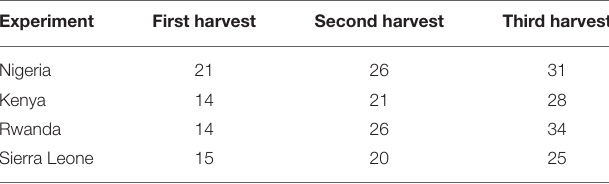
TABLE 4 | Harvesting periods (days after emergence for Nigeria, Kenya and Rwanda; days after planting for Sierra Leone) followed at each intermediate dry matter determination in different